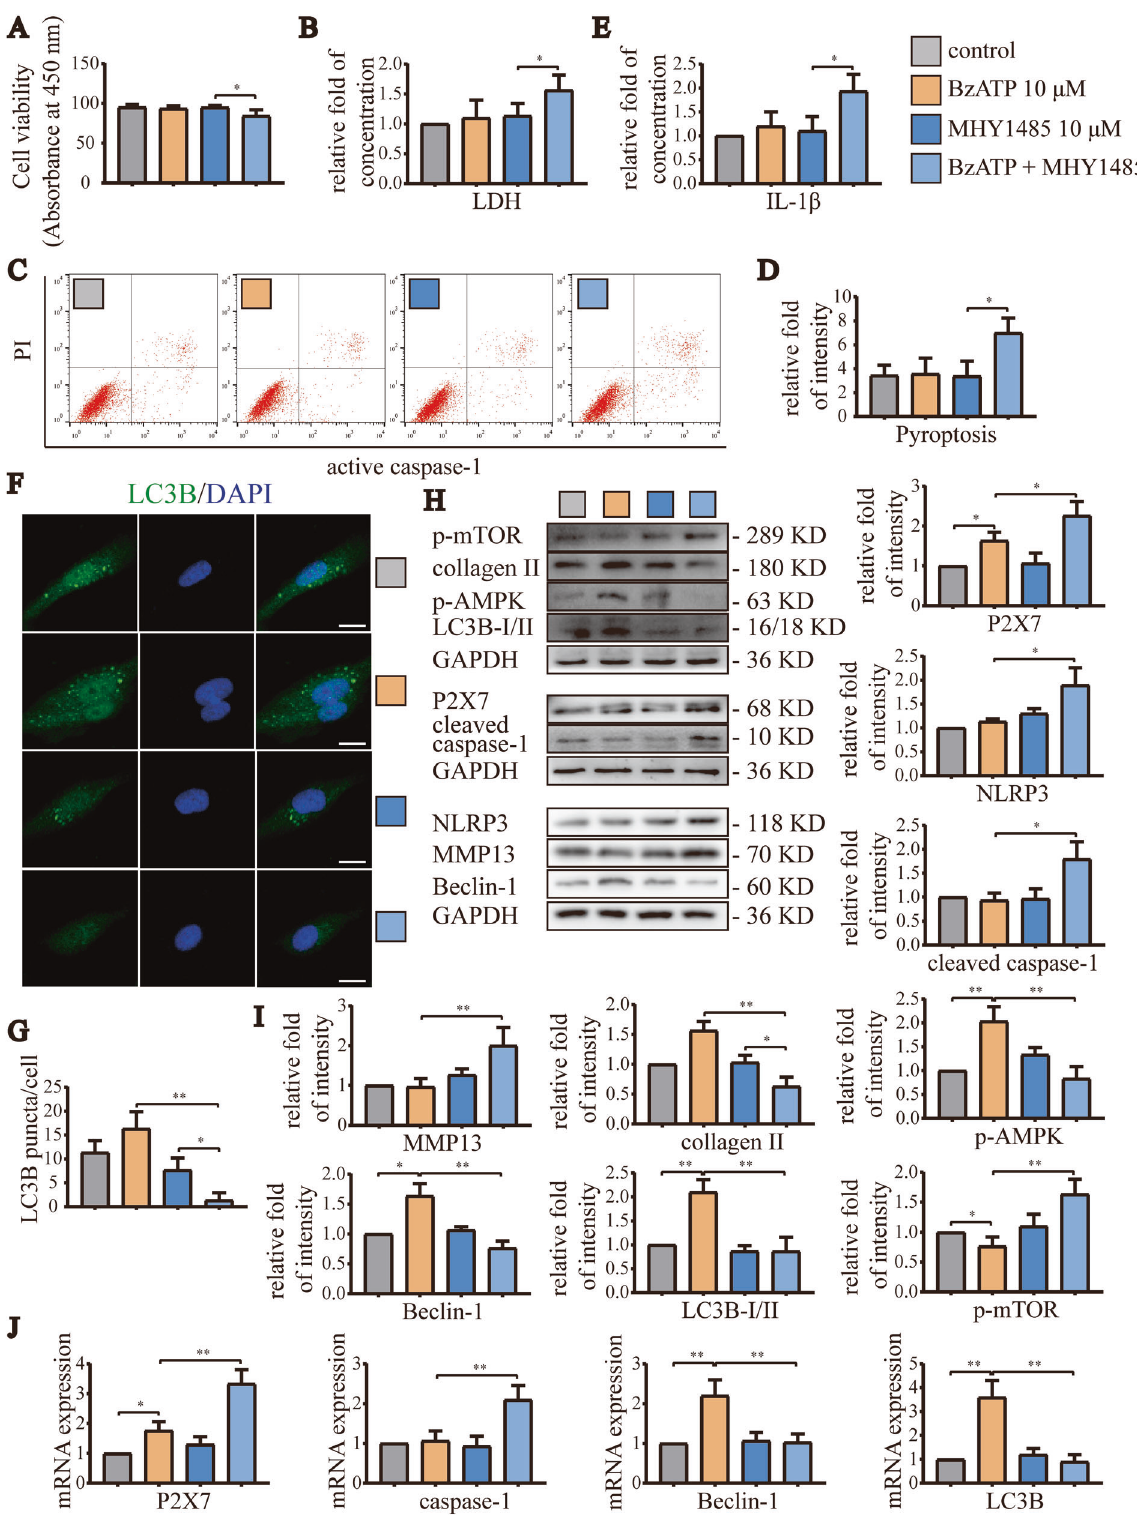
Fig. 6 Moderate activation of P2X7 reduced pyroptosis through AMPK/mTOR-induced autophagy. A CCK-8 assays were used to evaluate cell viability in each group. Absorbance was measured at a wavelength of 450 nm. B LDH release assays were used to detect the degree of cell damage. C Flow cytometry was used to detect the number and ratio of caspase-1/PI-stained cells, re fl ecting the severity of cell pyroptosis. D Statistical data for stained cells. E ELISA was used to detect IL-1 β content in cell culture supernatants for each group. F Cell fl uorescence experiments were used to detect the fl uorescence intensity and puncta number of cell LC3B staining, re fl ecting the level of autophagy (scale bar: 10 μ m). G Statistical data for LC3B puncta/cell. H , I Western blotting and J RT-qPCR were used to detect protein and mRNA expression levels of P2X7, NLRP3, caspase-1, mTOR, AMPK, LC3B, Beclin-1, MMP13, and collagen II. Data are presented as means ± standard deviations of at least three independent experiments. * p < 0.05, ** p < 0.01. Cell Death Discovery (2021)